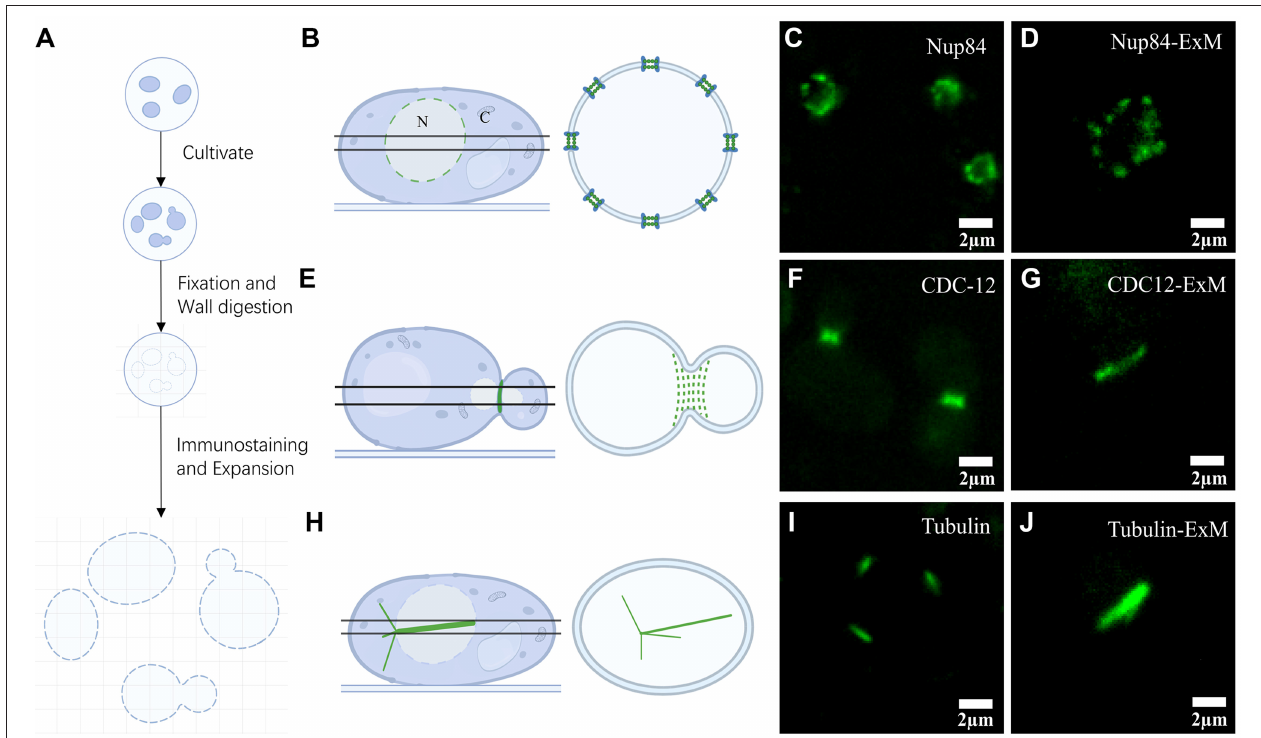
FIGURE 1 | Expansion microscopy of yeast. (A) Schematic diagram of the steps in the yeast expansion protocol. (B) Illustration representing axial imaging with views of Nups located at the equator. (C) Pre-expansion wide-field imaging of Nup84. (D) Post-expansion wide-field imaging of Nup84. (E) Diagram of septin structural illumination during division. (F) Pre-expansion wide-field imaging of septin CDC12. (G) Post-expansion wide-field imaging of septin CDC12. (H) Graphical demonstration of α -tubulin in yeast. (I) Pre-expansion wide-field imaging of α -tubulin. (J) Post-expansion wide-field imaging of α -tubulin. Scale bars, 2 µ m (C, D, F, G, I, J) . All bars were physical scales before correction with expansion